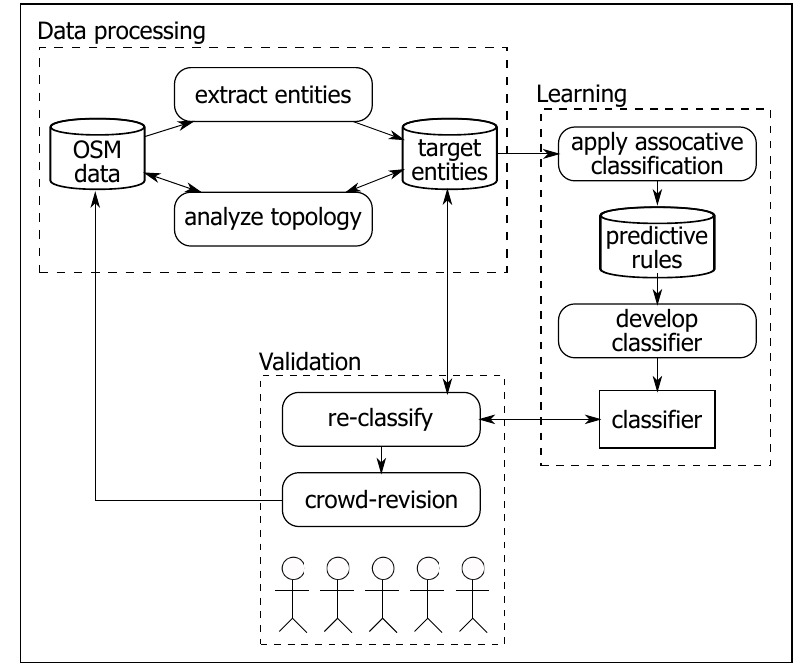
Figure 3. Conceptual structure of the rule-guided classification